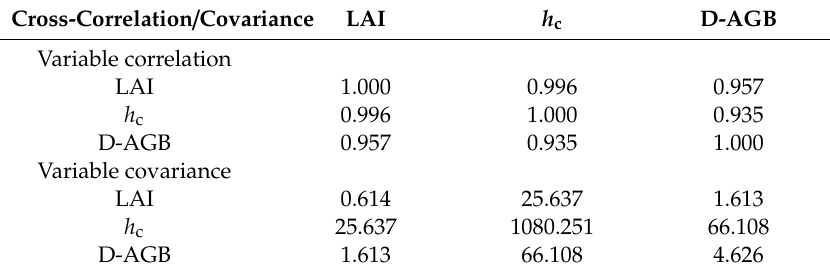
Table 2. Cross-correlation / covariance between LAI, cumET c , and D-AGB from the second stage of regression.